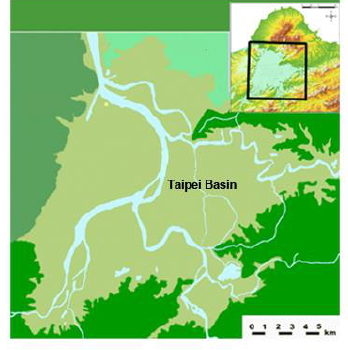
Figure 1. Taipei basin of